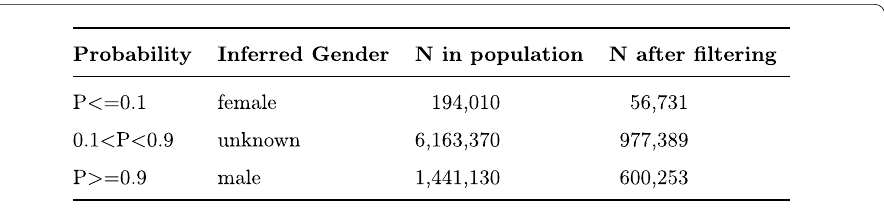
Figure 1 Inferring name for gender recognition. Due to some names being used for both males and females, we assign a probability of being male to each candidate based on the fraction of times their first name was assigned to a male baby in the name dataset. We define gender probability cutoffs of 0.1 and 0.9 consistent with previous studies [38]. Our gender recognition yielded 11.87% females and 88.13% males out of all users with names. All in all we found 194,010 females, 1,441,130 males, and 6,163,370 unknowns